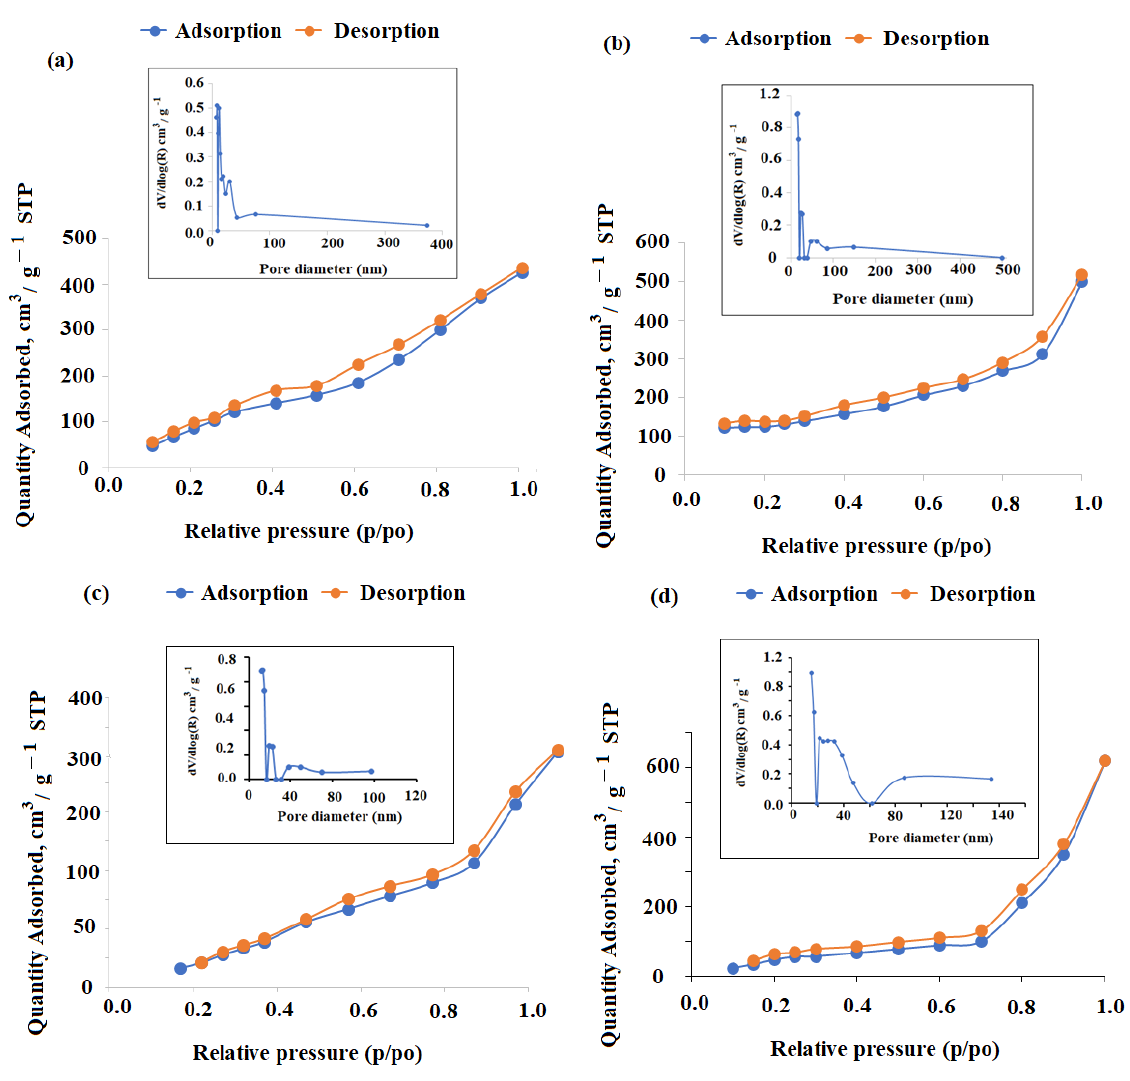
Figure 5. BET graphs of adsorption-desorption of N 2 gas on the surface of fly ash loaded chitosan ( a ) CSF, ( b ) FA-CSF1, ( c ) FA-CSF2, and ( d ) FA-CSF3 films and their pores diameter.